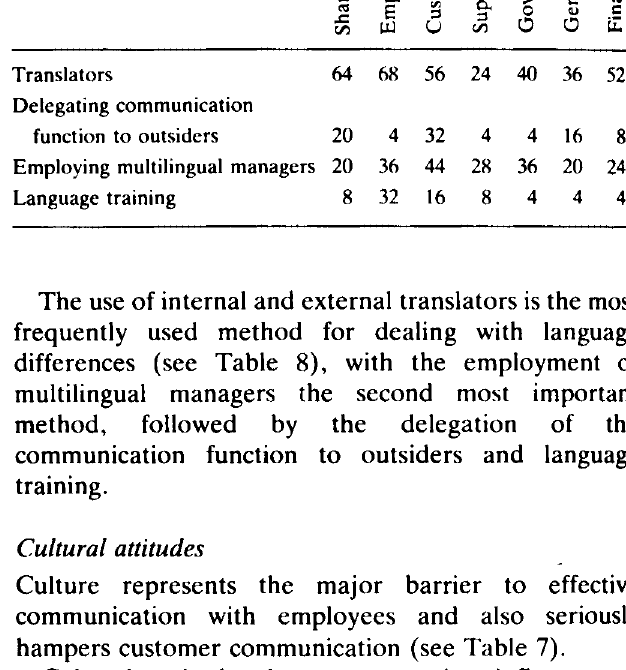
Figure 2 The communication mix Table 7 Percentage of business enterprises regarding